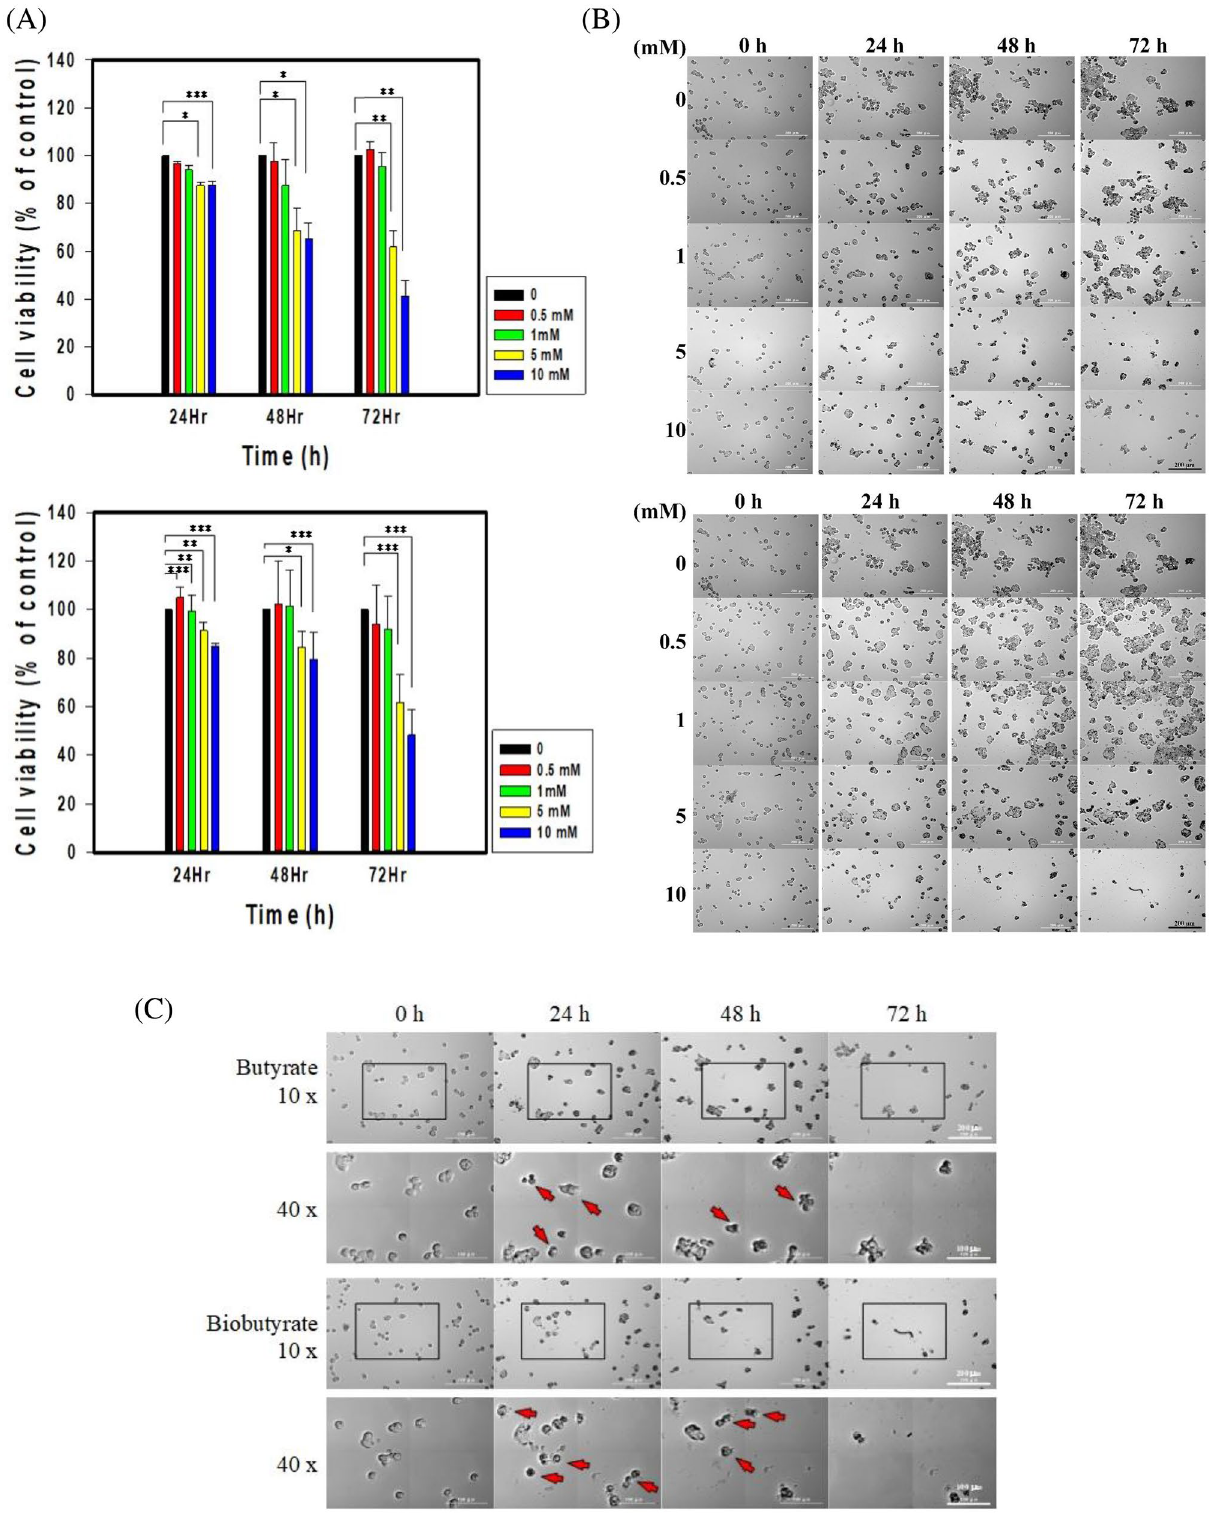
Figure 2. Cytotoxic effect of butyrate and biobutyrate on cancer cells. HT29 cancer cells were administrated with various concentrations of either butyrate or biobutyrate from EcN-BUT. ( A ) Cell viability by the MTT assay. The viability of HT29 cells was determined after the treatment of butyrate (top) or biobutyrate (bottom). The data was expressed as the mean ± SD from three independent experiments and analyzed by the GraphPad Prism 7 software ( *p < 0.05, **p < 0.01 and ***p < 0.001 vs . control based on one-way ANOVA) and graphs were prepared using SigmaPlot 10.0 (Systat Software, San Jose, CA). ( B ) Cell morphology analysis by Cytation 5. Cell morphology was observed after the treatment of butyrate (top) or biobutyrate (bottom) at the indicated time. ( C ) Magnified images of cell morphology. The 10-(× 10) and 40-fold (× 40) magnified images of cell morphology were taken from (B). Apoptotic bodies were shown by